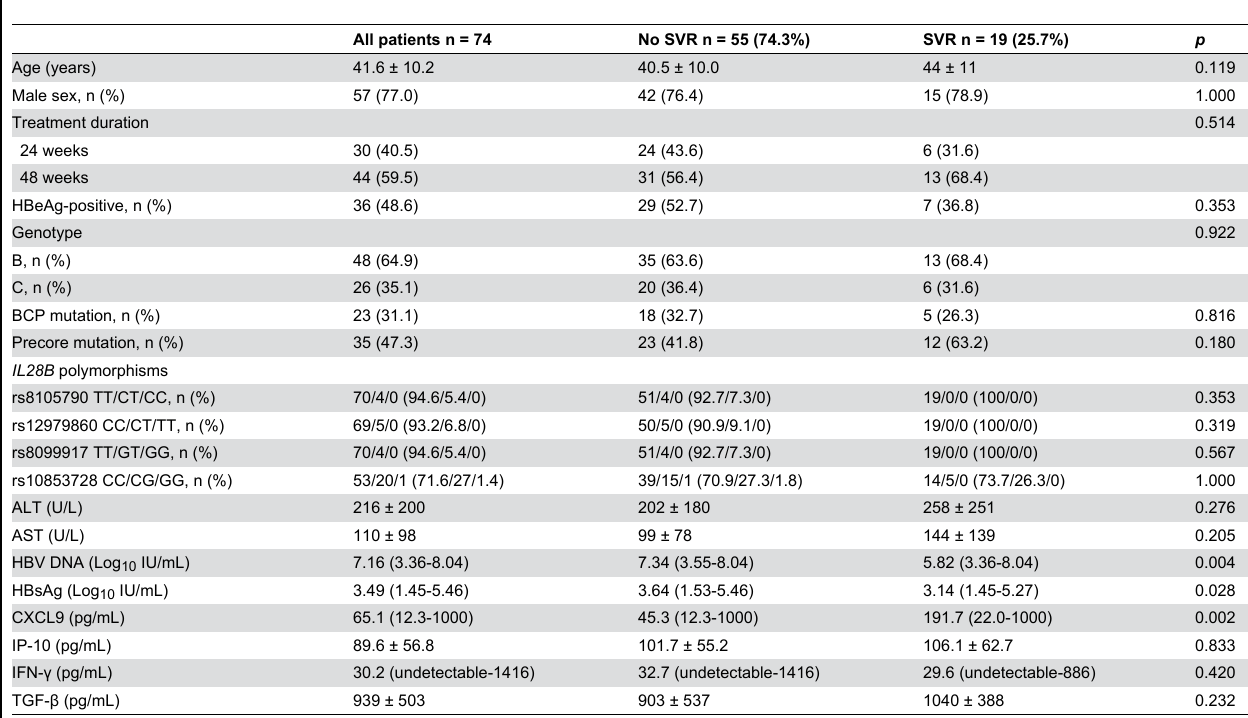
Table 1. Baseline characteristics of the CHB patients with or without sustained virological response (SVR).